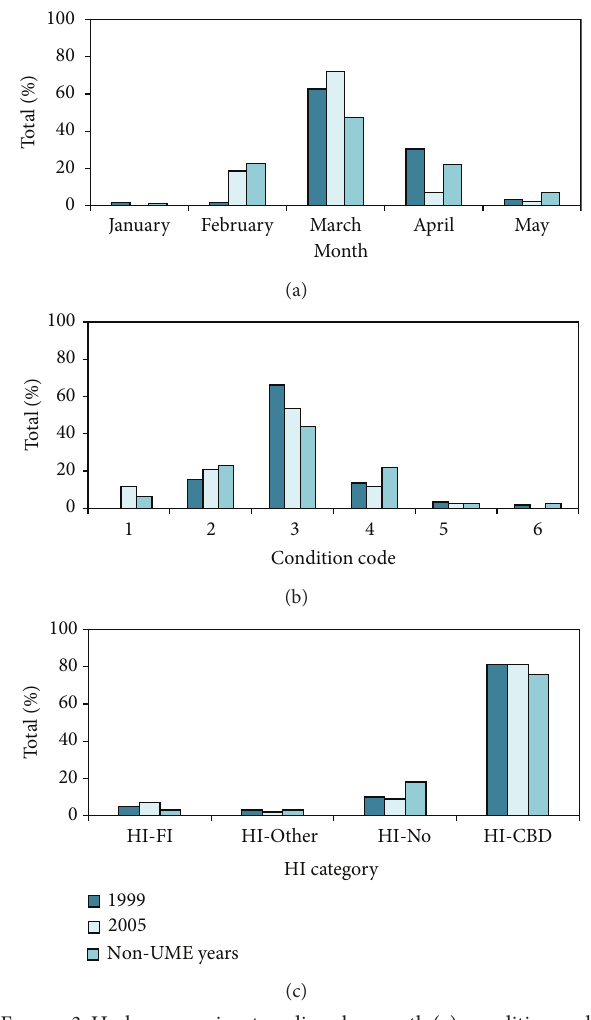
Figure 3: Harbor porpoise strandings by month (a), condition code (b), and human interaction (HI) category (c) as a percentage of the total for 1999 ( 𝑛 = 59 ), 2005 ( 𝑛 = 43 ), and non-UME years ( 𝑛 = 160 ). Condition codes are (1) live animal, (2) carcass-fresh dead, (3) carcass-moderately decomposed, (4) carcass-advanced decomposition, (5) carcass-mummified or skeletal remains, and (6) disposition unknown. HI categories are HI-FI (evidence of Fishery Interaction), HI-Other (other evidence of HI), HI-No (no evidence of HI), and HI-CBD (HI could not be